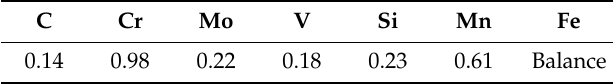
Table 1. Chemical compositions of 12Cr1MoV steel